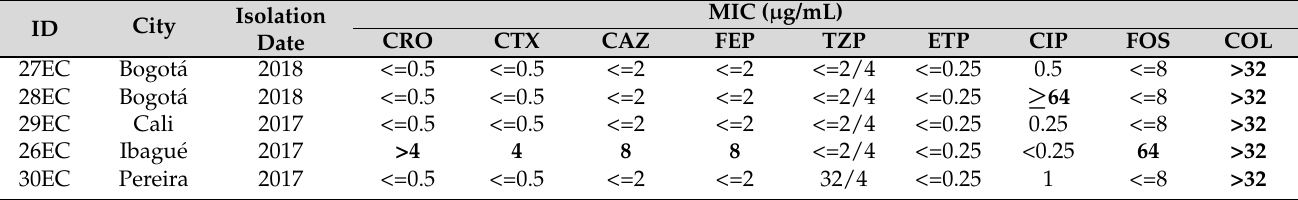
Table 1. Demographic and minimum inhibitory concentration (MIC) for colistin and additional antimicrobial agents in E. coli isolates tested harboring the mcr-1